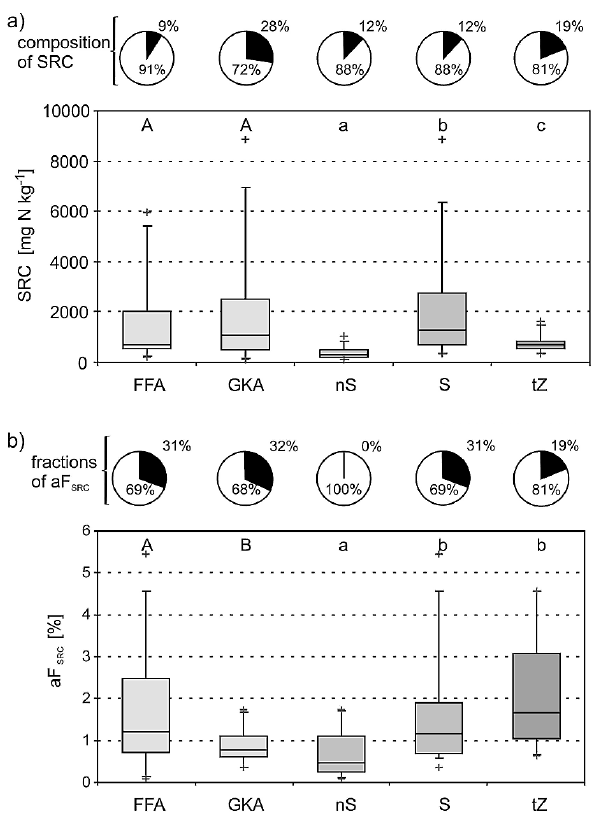
Fig. 2. FFA, GKA, nS, S and tZ indicate Fuhrberger Feld, Großenkneten, non sulphidic, sulphidic and transition zone aquifer material, respectively. White circular segments represent fractions derived from C org and black segments fractions derived from total- S values. Different uppercase letters above the box-plots indicate significant differences of SRC and sF SRC values between FFA and GKA material, different small letters show significant differences between nS, S and tZ (Kruskal–Wallis Test, P < 0 . 05). (a) The stock of reduced compounds (SRC) and its composition in the vari- ous groups of aquifer material. The composition of SRC was calcu- lated from C org and total-S values (Sect. 2.5). (b) Fraction of SRC available for denitrification during incubation (aF SRC ). The aF SRC and its composition was calculated as described in Sect.